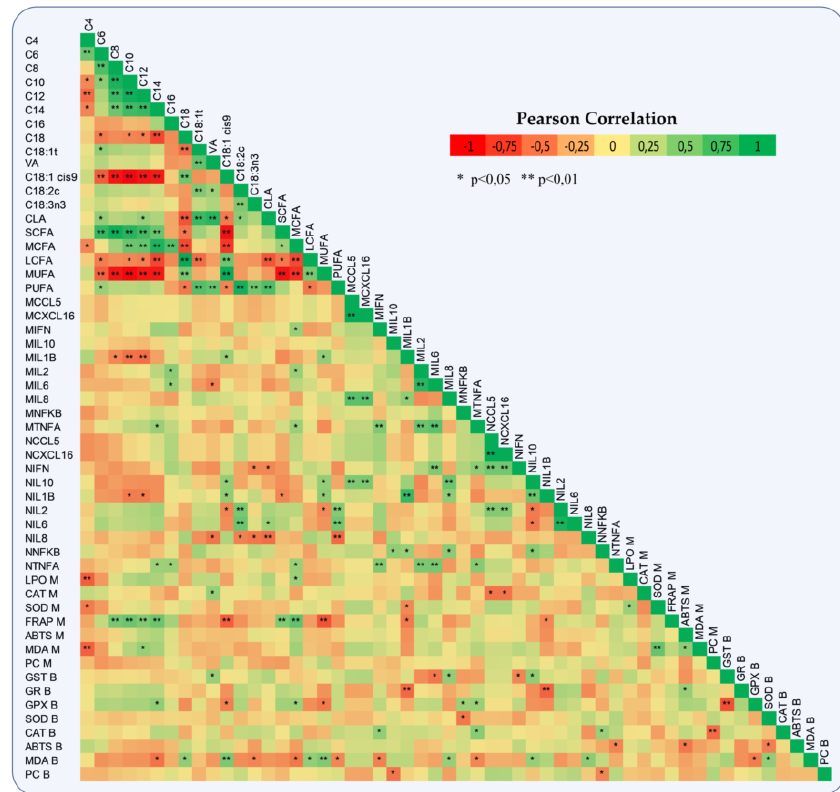
Figure 4. Heat-map represents a Pearson correlation of milk fatty acids, immune system gene expression in monocytes and neutrophils, antioxidant enzymes activities, total antioxidant capacity, and oxidative indices in both blood plasma and milk of ewes. In immune system genes, M = monocytes and N = neutrophils, while in antioxidants B = blood plasma and M = milk. CCL5: C-X-C motif chemokine 5, CXCL16: C-X-C motif chemokine ligand 16, INFG: Interferon γ , IL1B: Interleukin-1 beta,